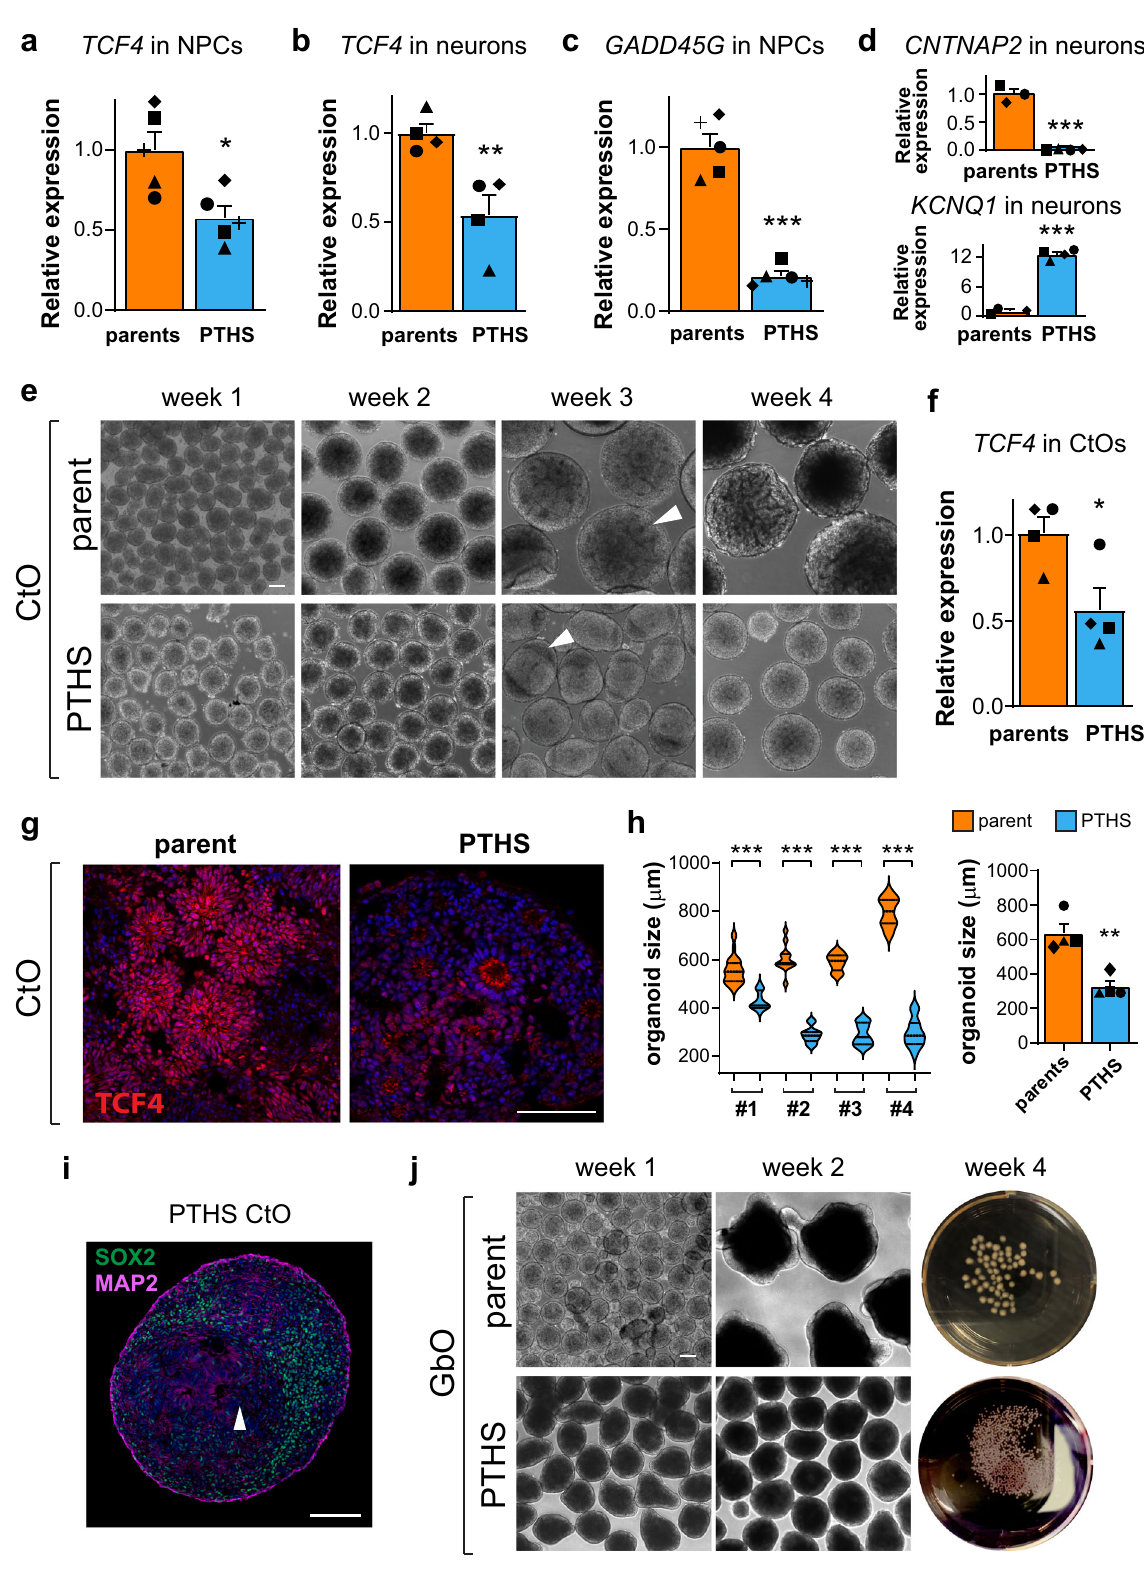
development proceeds (Fig. 2a). Dissimilarly, PTHS CtOs and GbOs possess less evident MAP2 labeling, even at later stages of development (Fig. 2a and Supplementary Fig. 2b). Parental CtOs exhibit a typical pattern of cortical development, recapitulating the temporal progression of neuronal differentiation in the human cortex, in which deep-layer neurons (CTIP2 + cells)